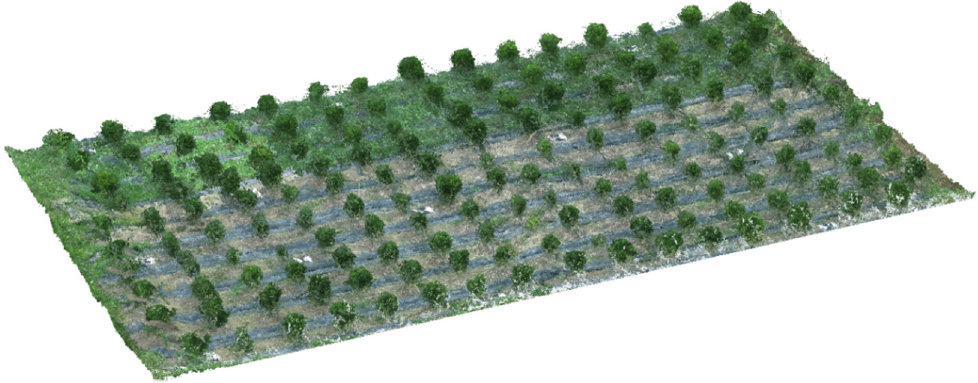
Figure 4. Point cloud results of the experimental site.